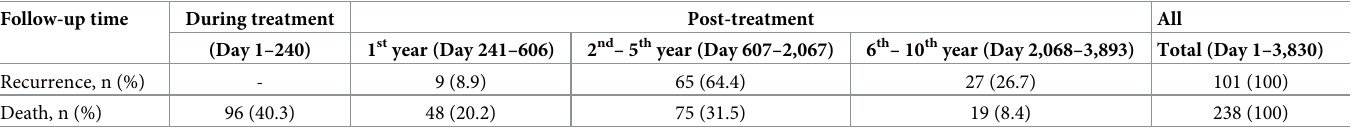
Table 3. TB recurrence and death of TB patients during different periods of follow-up in Dale district, South Ethiopia. Follow-up time During